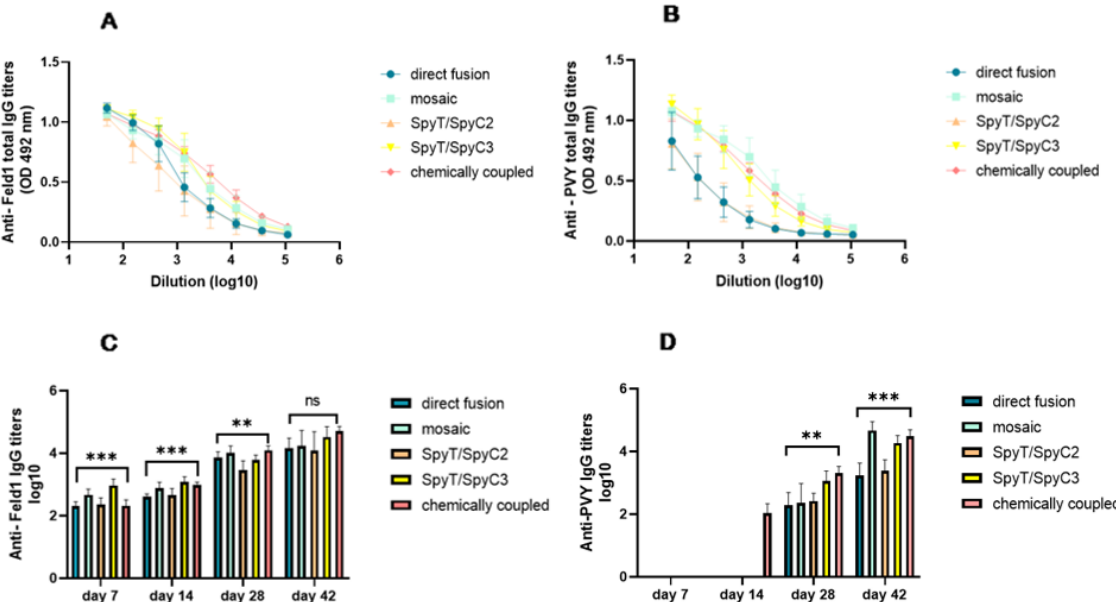
Figure 7. Fel d 1 IgG titer analysis after vaccination with PVY–Fel d 1 vaccine variants. ( A )—Fel d 1-specific IgG titers on Day 42 for the groups vaccinated with PVY–Fel d 1 variants measured at OD 492 nm; ( B )—PVY CP-specific IgG titers on Day 42 for the groups vaccinated with PVY–Fel d 1 variants measured at OD 492 nm; ( C )—Log 10 values (mean ± SEM) of Feld1-specific IgG titers for the groups vaccinated with PVY–Fel d 1 VLPs on Days 7, 14, 28 and 42; ( D )—Log 10 values (mean ± SEM) of PVY CP-specific IgG for the groups vaccinated with PVY–Fel d 1 VLPs on Days 7, 14, 28 and 42. ( C , D )—Statistical analysis using one-way ANOVA in GraphPad Prism 9.0. Vaccine groups n = 5. One representative experiment is shown. A value of p > 0.05 was considered statistically significant (ns—not significant; ** p < 0.001; *** p <